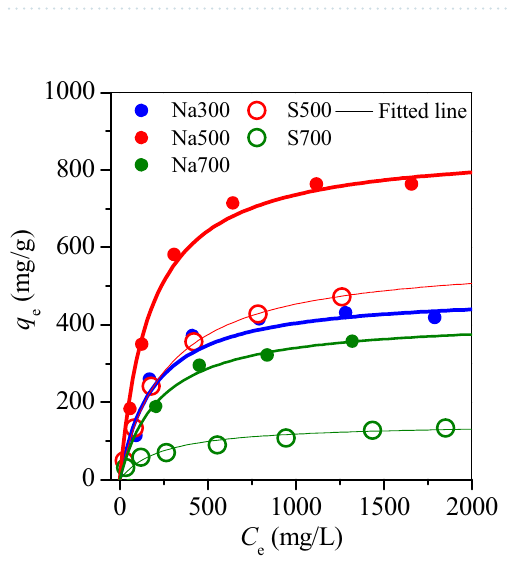
Figure 4. SEM pictures of the GTS and prepared adsorbents.